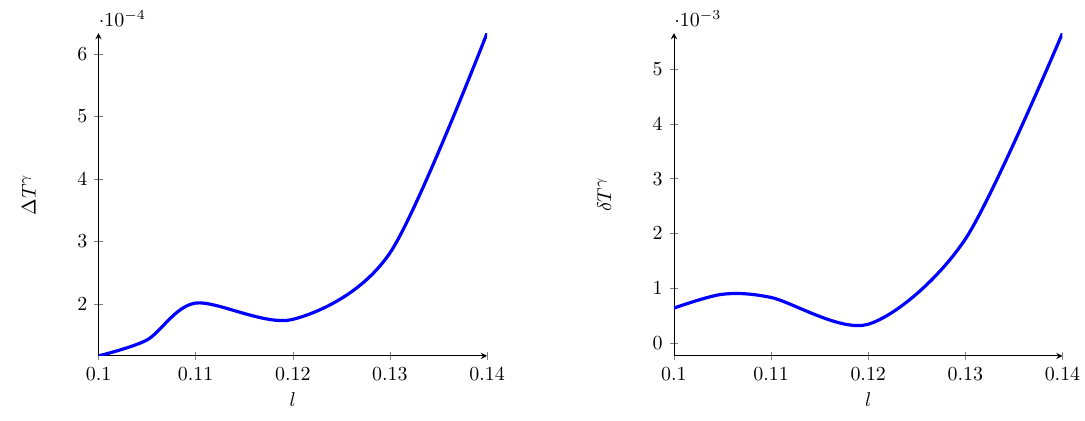
Figure 2 . On the left the relative estimated error of the (cid:13) correction to the temperature averaged over M is plotted for di(cid:11)erent values of the interval boundary l . On the right hand side the